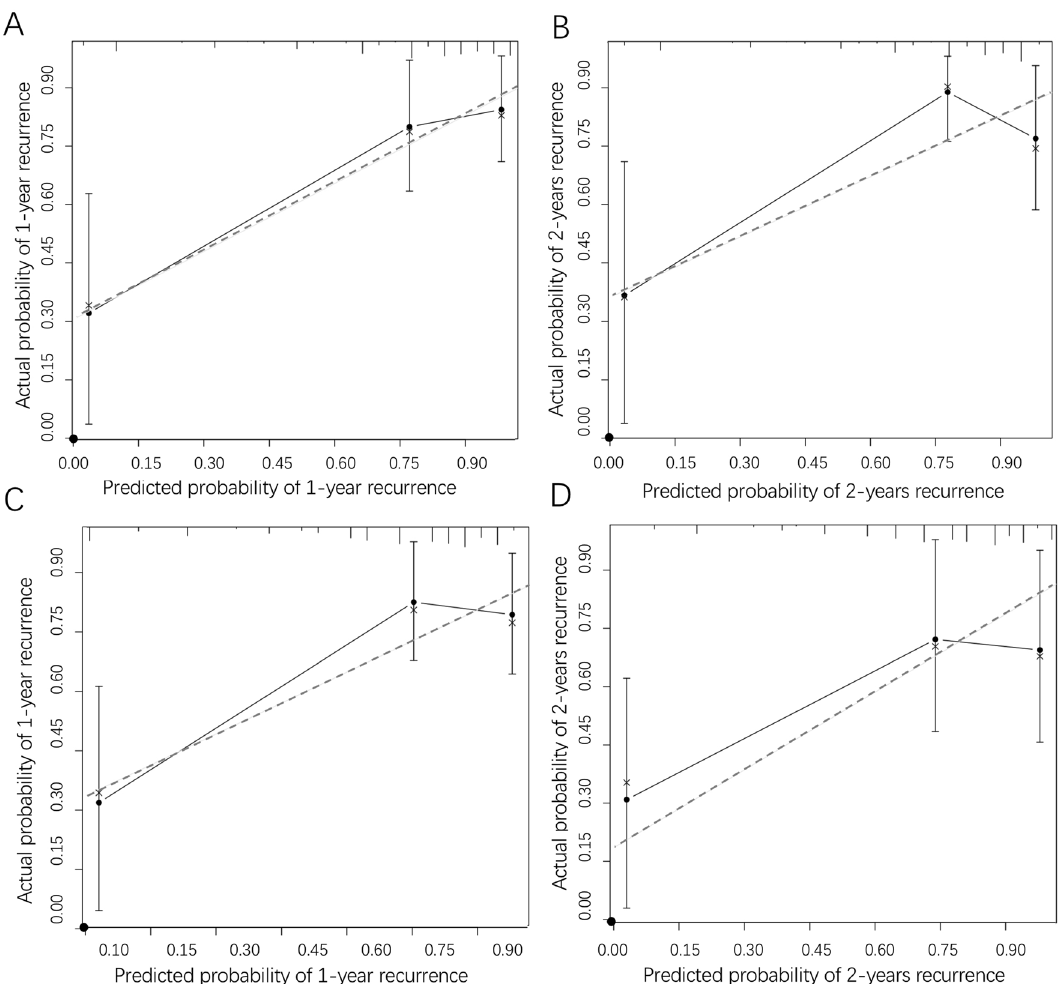
Figure 3. The calibration curves of internal ( A , B ) and external ( C , D ) validation of the nomogram constructed in the training group based on CTCs count and M-CTC percentage. The predicted probabilities of 1-year and 2-year recurrence were consistent with the actual recurrence proportions of ovarian cancer patients. The calibration plots were generated by the “rms” package of R software 18